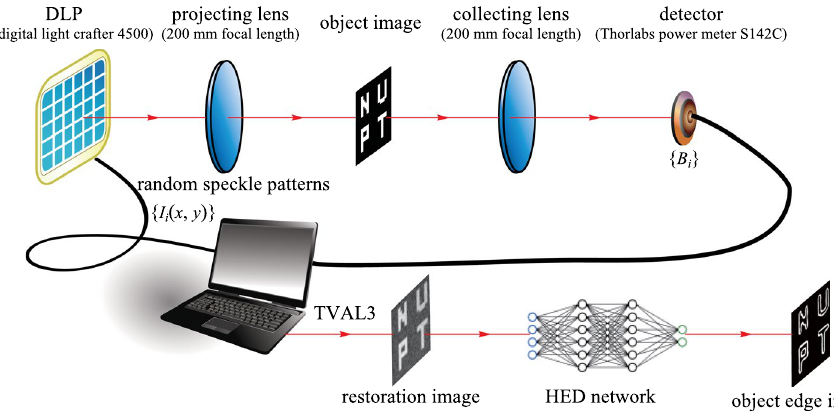
Fig. 3 Experimental setup of the ghost edge detection scheme based on HED network. DLP: digital light